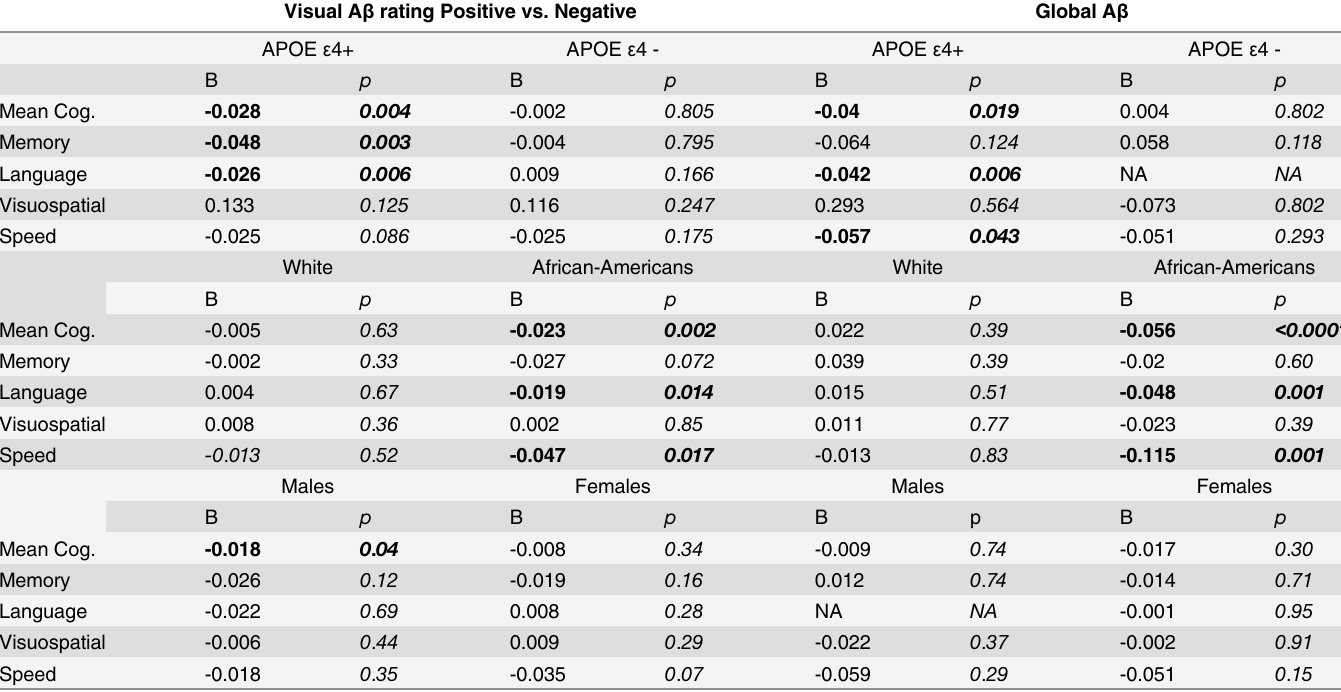
Table 3. Brain A β in relation to the rate of cognitive decline during the decade prior to PET scan among non-demented participants, stratified by APOE ε 4 genotype, ethnicity, and gender. Visual A β rating Positive vs. Negative